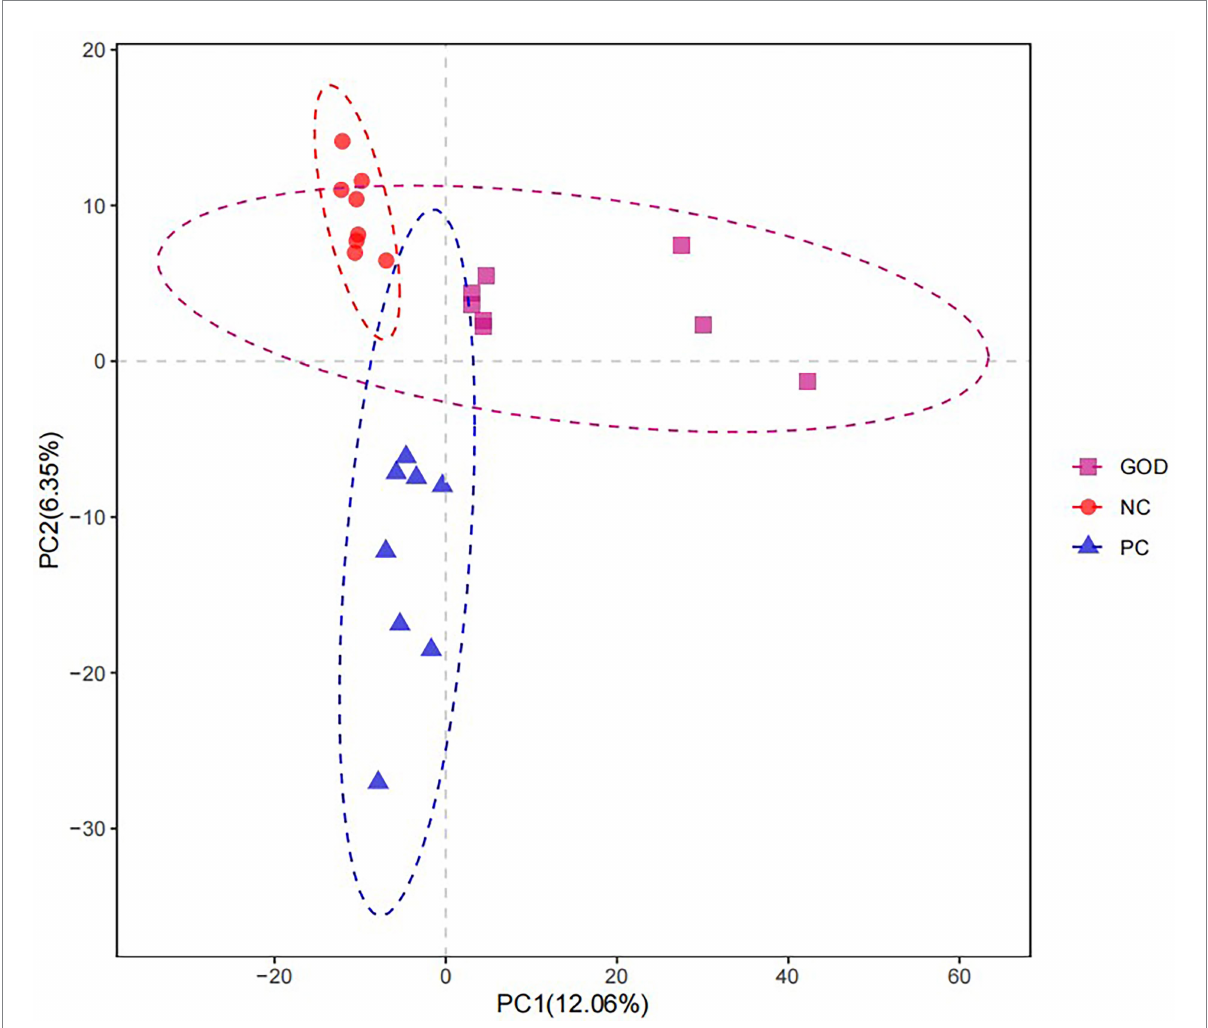
FIGURE 2 Partial least squares discriminant analysis (PLS-DA) diversity of piglet gut microbiota among groups. NC, negative control (piglets were free of the challenge); PC, positive control (piglets were challenged with enterotoxigenic E. coli on the 11th day of the experiment); and GOD, PC piglets supplemented with 200 g/t glucose oxidase. Samples were analyzed on the 21st day of the